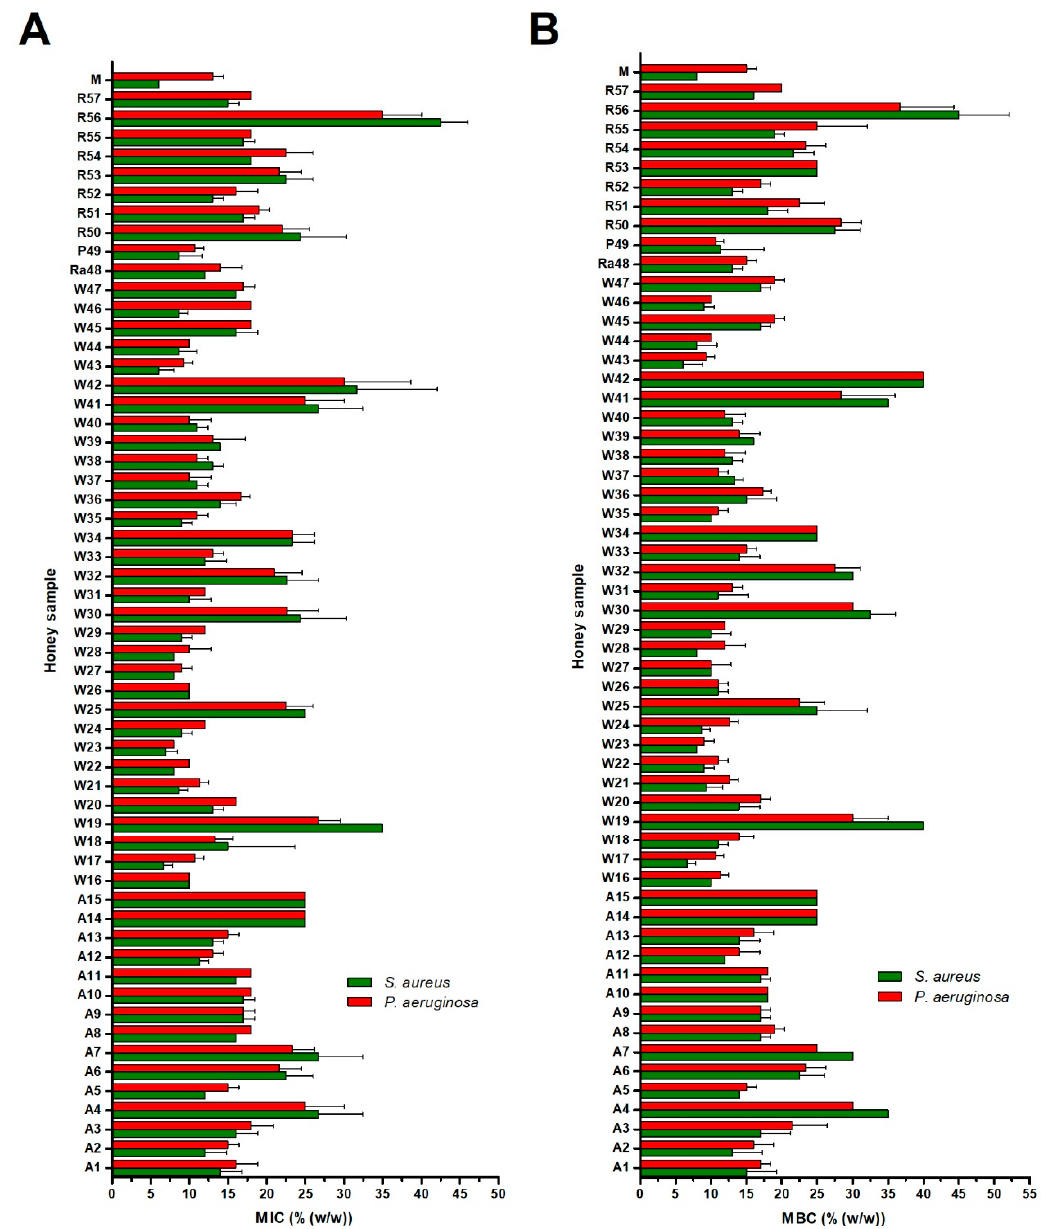
Figure 2. Antibacterial activity of blossom honey samples ( n = 57) and medical-grade manuka against Staphylococcus aureus and Pseudomonas aeruginosa isolates. Activity was determined with a minimum inhibitory concentration (MIC) ( A ) and minimum bactericidal concentration (MBC) ( B ) assay. The MIC and MBC were defined as the lowest concentration of honey solution (%) inhibiting bacterial growth and killing the bacteria, respectively. Honeys: M—manuka honey, R—rapeseed, P—phacelia, Ra—raspberry, W—wildflower, A—acacia. The data are expressed as the mean values with standard deviation (SD).